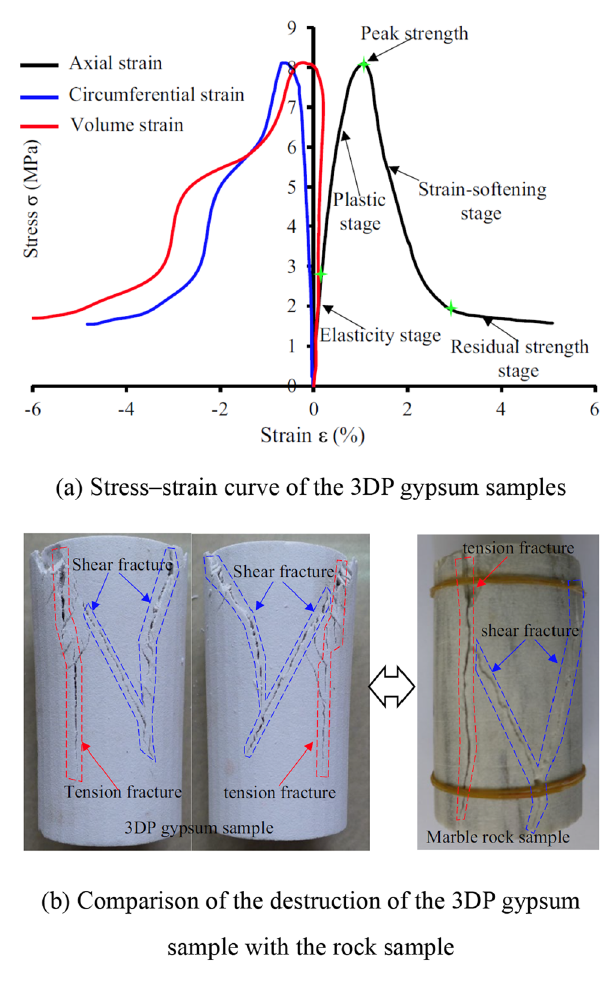
Fig. 6 Experimental results of 3DP gypsum samples (Song et al. 2018)